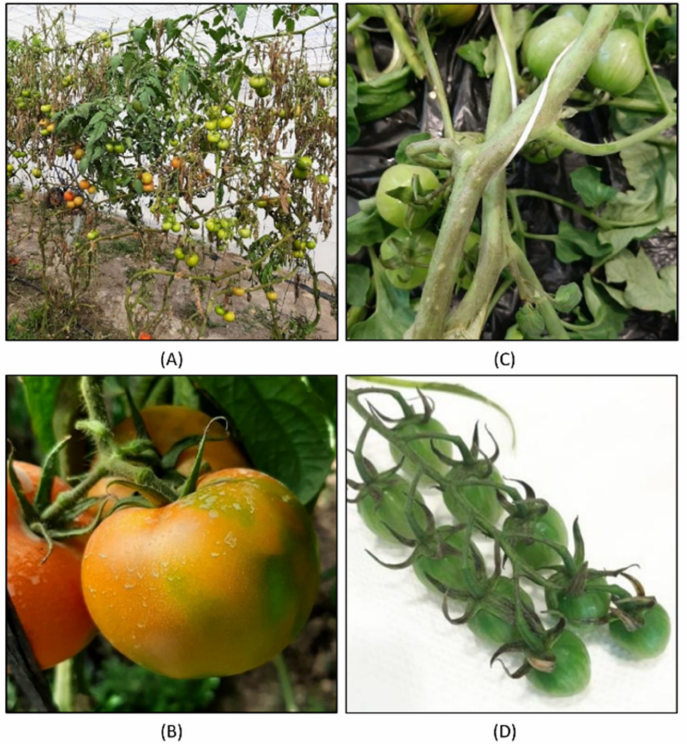
Figure 2. Tomato plants and fruits exhibiting virus-like symptoms. ( A , B ) correspond to the green- house where sample R19-07 was collected in Murcia. Tomato fruits exhibited fruit blotching and discoloration. ( C , D ) correspond to another greenhouse in Almer í a where sample R19-12 was col- lected, and tomato plants exhibited